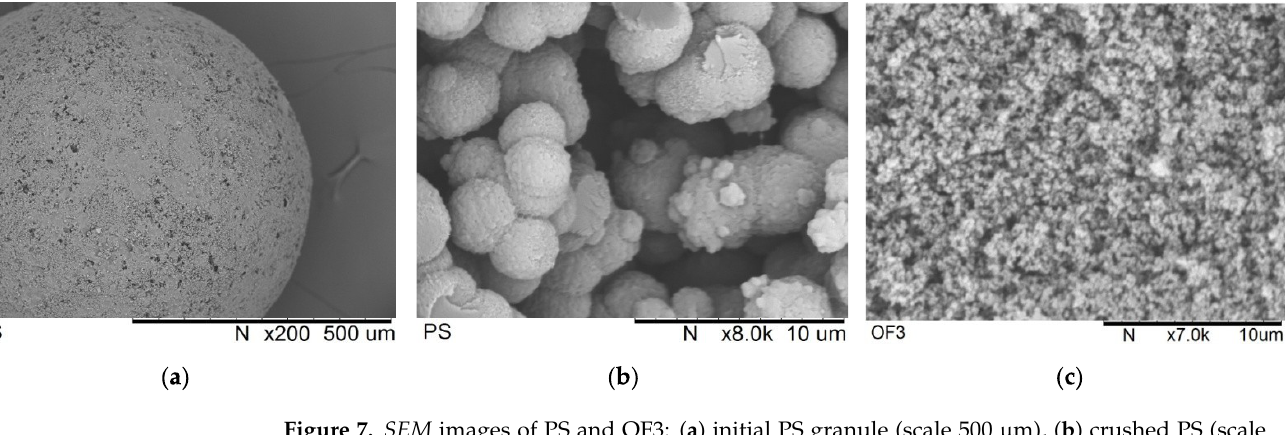
Figure 7. SEM images of PS and OF3: ( a ) initial PS granule (scale 500 µ m), ( b ) crushed PS (scale 10 µ m), and ( c ) crushed OF3 (scale 10 µ m).